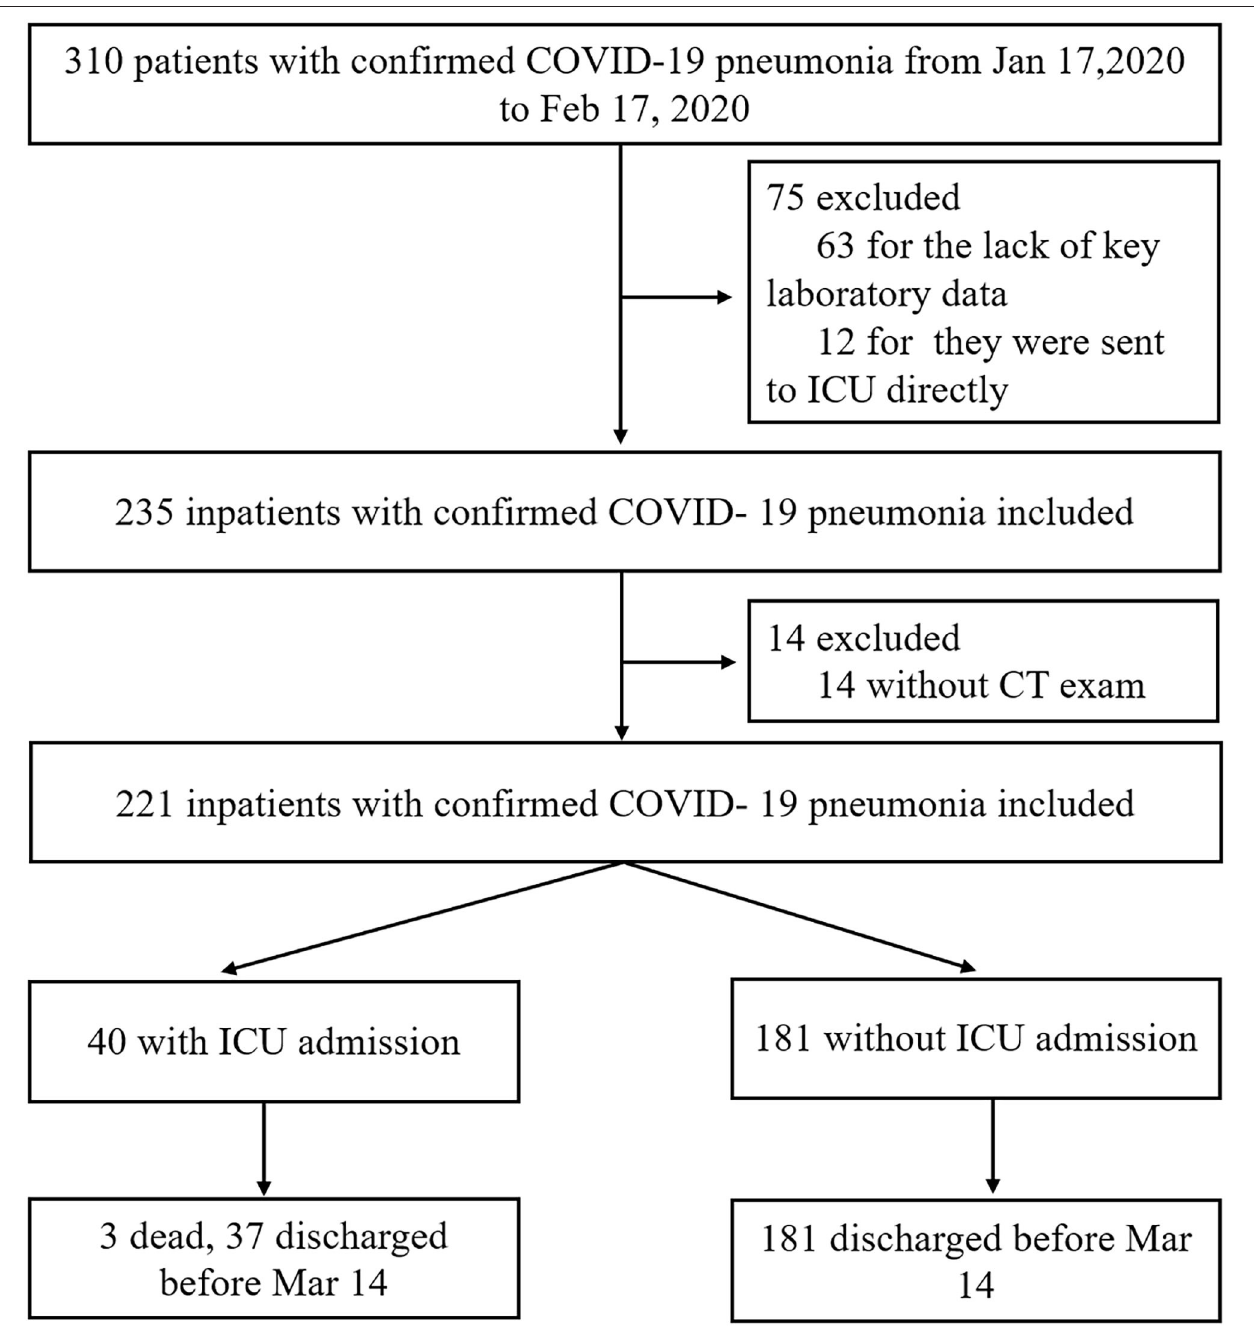
FIGURE 1 | Study flow